Question: In one sentence, what is this figure communicating?
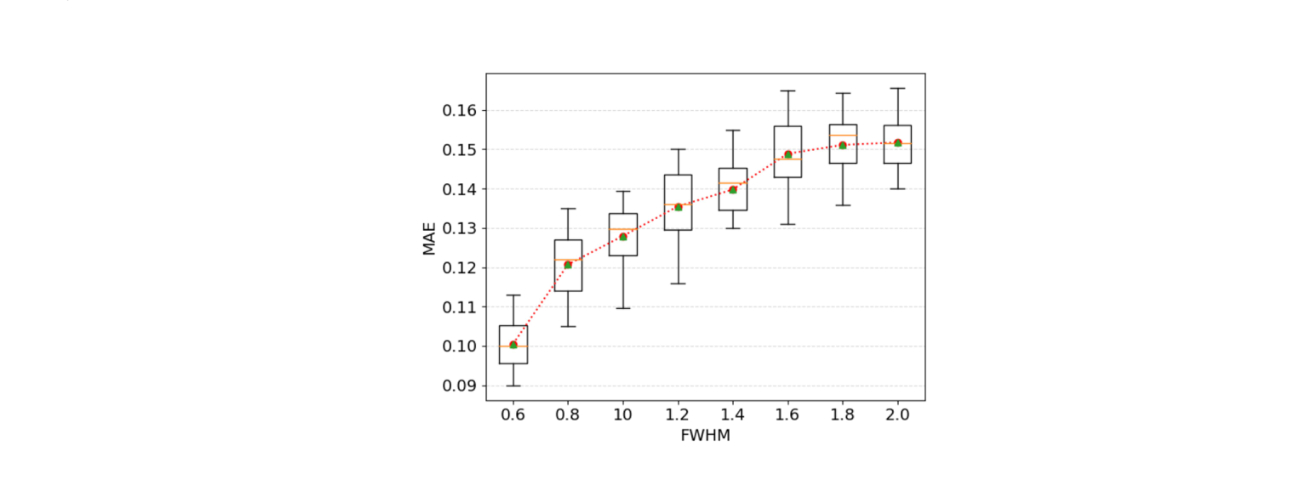
Answer: This figure shows MAE of new sets of simulated images obtained by our methods (from FWHM = 0.5 to FWHM = 2.0). The black straight line stands for mean values of all images and the red dotted line stands for MAEs of the same image with different blur levels.